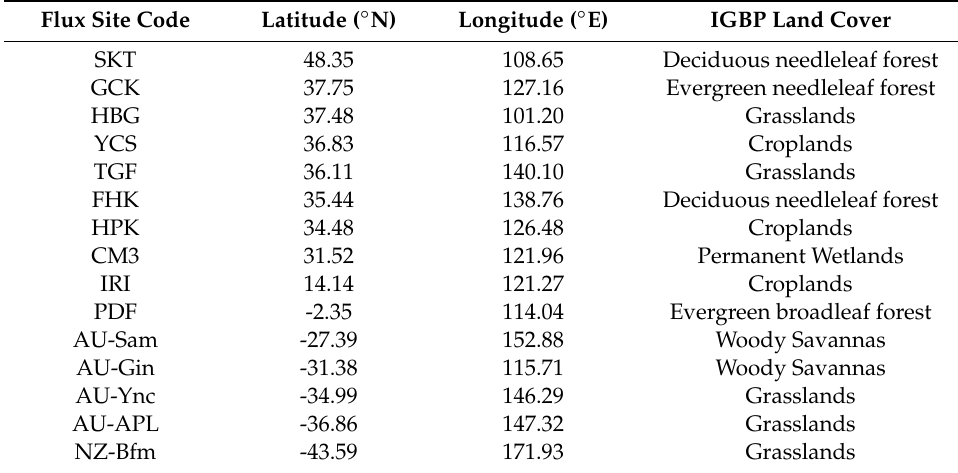
Table 1. List of selected sites used in this study. IGBP denotes the International Geosphere–Biosphere Programme, and IGBP land cover type is derived from the MODIS Land Cover Type (MCD12Q1) 500 m